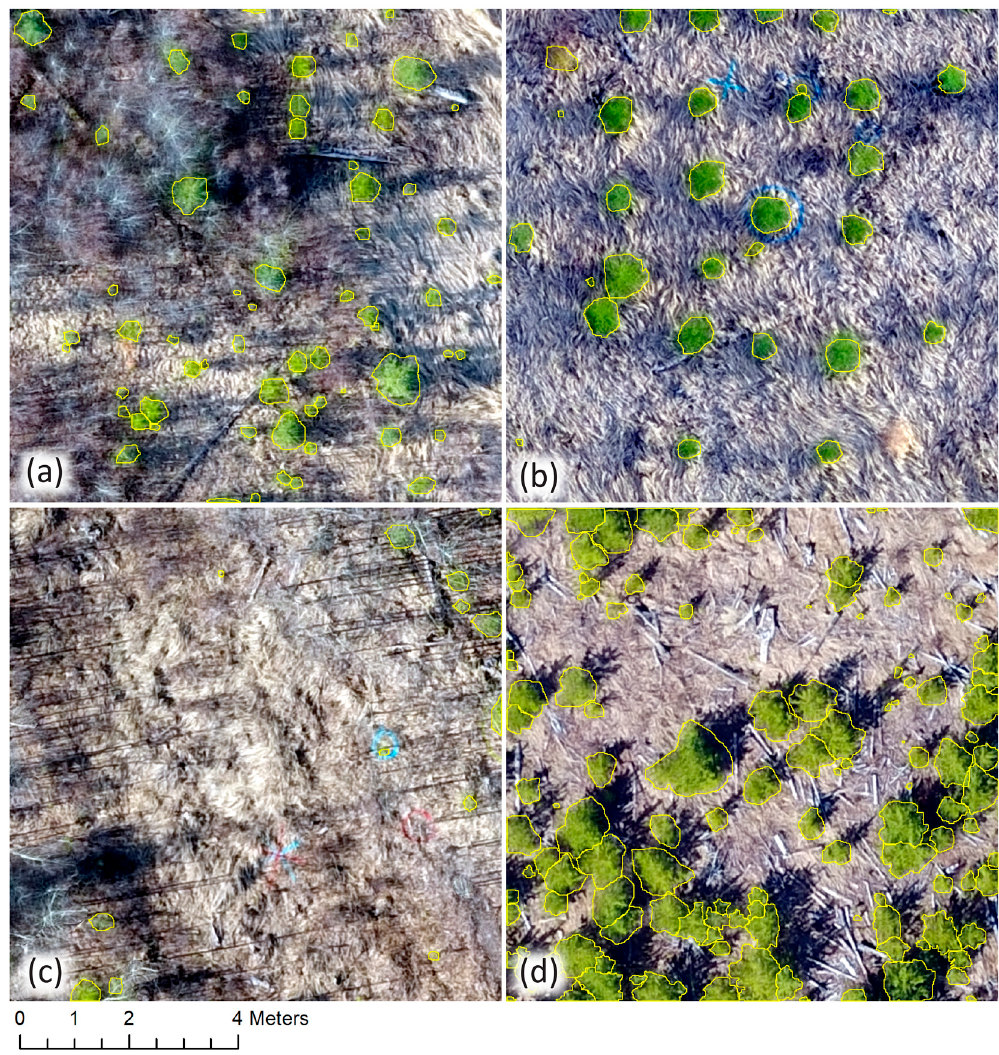
Figure 2. Subset image tile examples representing various individual tree crown (ITC) arrangements and lighting conditions found in training, internal validation, and external validation tiles. Manually delineated ITC are drawn in yellow. Crowns with a range of diameters were common to most subset image tiles. ( c , d ) exemplify two extremes of ITC density found across all subset image tiles. ( a , c ) exemplify the presence of leafless deciduous trees. Various lighting conditions are displayed in all panels, where ( b ) is representative of imagery with minimal shadows.